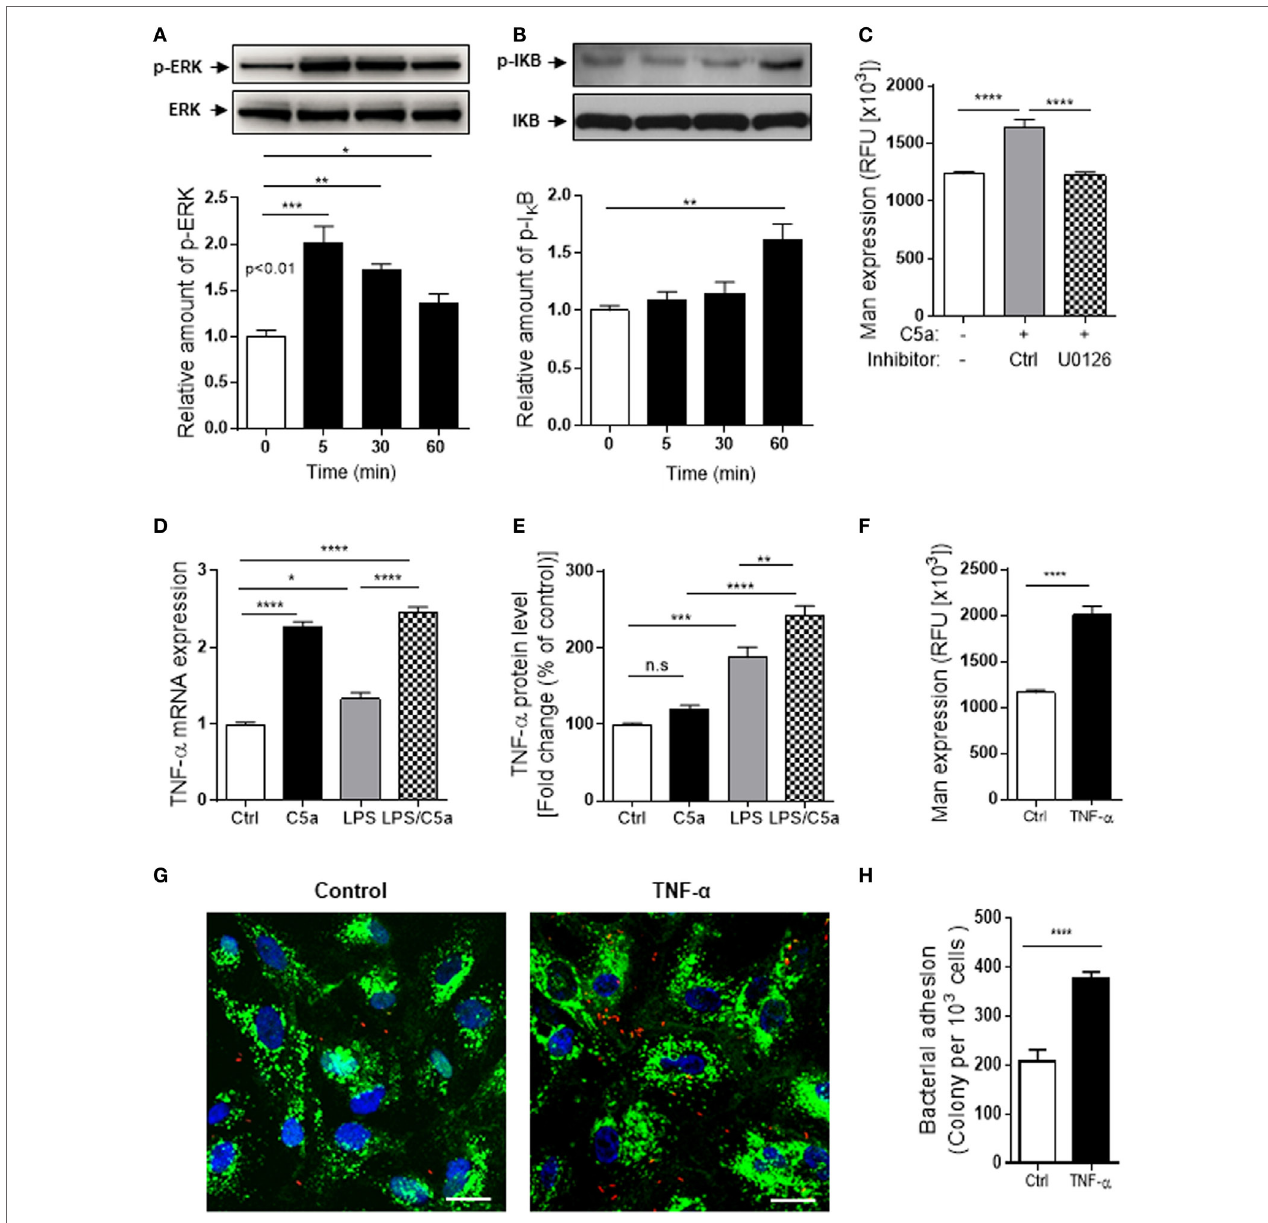
FigUre 6 | Intracellular signaling/molecules responsible for the action of C5a on Mannosyl residue expression. (a,B) Western blot analysis for ERK1/2 and I κ B phosphorylation in renal tubular epithelial cell (RTEC) after C5a (10 nM) stimulation for up to 60 min. In each set of blots, the top row of bands corresponds to incubating membrane with appropriate anti-phospho-antibody and the bottom row of bands corresponds to incubating membrane with appropriate total antibody. Relative amounts of protein phosphorylation are shown in the lower panel of each set of blots. Data were analyzed by one-way ANOVA ( n = 3/group, resulting from three independent experiments). (c) Effect of inhibition of ERK1/2 pathway on Man expression in RTECs assessed by fluorescence intensity-based microplate assay. RTEC monolayers were pre-incubated with C5a for 24 h in the presence of ERK1/2 pathway inhibitor (U0126, 10 μ M) and the vehicle control (DMSO) then were used for quantification of Man expression. Data were analyzed by unpaired two-tailed Student’s t -test ( n = 9–12 individual wells per group). A representative result of three experiments is shown. (D,e) Production of TNF- α in RTEC that had been treated with C5a (10 nM) and/or LPS (800 ng/mL) for 24 h and subjected to RT-qPCR (D) and ELISA (e) . Data were analyzed by one-way ANOVA with Tukey’s multiple comparisons ( n = 3/group, resulting from three independent experiments). (F) Man expression in RTEC that had been pre-treated with recombinant human TNF- α (10 ng/mL) or vehicle control (BSA) for 24 h, evaluated by fluorescence intensity-based microplate assay. Data were analyzed by unpaired two-tailed Student’s t -test ( n = 9 replicate wells/group). A representative result of three experiments is shown. (g,h) Bacterial adhesion to RTEC. (g) Representative microscopic images of bacteria adhesion to RTEC that had been pre-treated with TNF- α for 24 h, then incubated with tri-iodothyronine and tetramethylrhodamine-labeled J96 for 1 h. Bacteria (red), Man (green) detected by fluorescein-labeled Galanthus nivalis lectin, and 4’,6-diamidino-2-phenylindole (blue) are shown. Scale bars, 25 µm. (h) Quantification of bound bacteria corresponding to the images shown in (g) . Data were analyzed by unpaired two-tailed Student’s t -test [ n = 6 individual images ( × 200 magnification) from two coverslips per group]. A representative result of three experiments is shown. * P < 0.05, ** P < 0.005, *** P < 0.001, **** P <